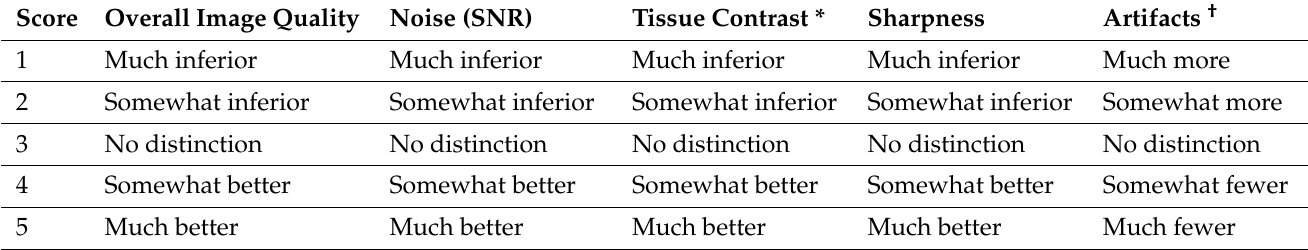
Table 2. Relative image scores: as compared with the vendor-provded T2 BLADE images (1: worst, 5: